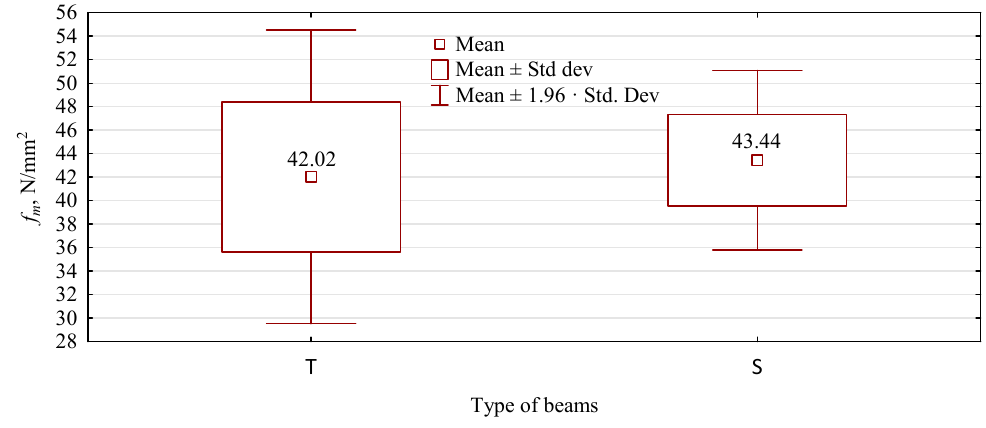
Figure 9. Static bending strength of analyzed beam types.